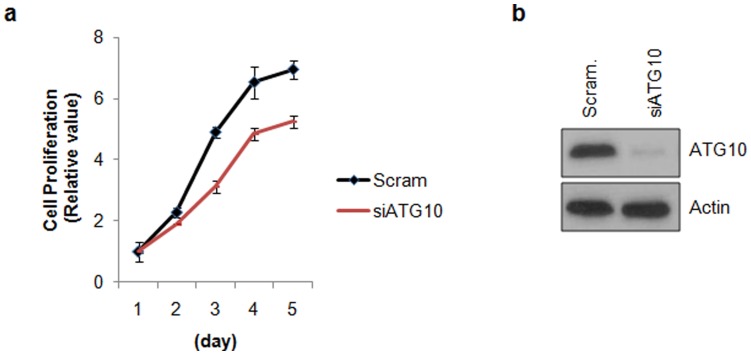
Silencing of ATG10 expression reduces cell proliferation in HCT116 cells.HCT116 cells were transiently transfected with either scrambled negative siRNA (Scram) or ATG10 specific siRNA (siATG10) then the cell proliferation rate was daily determined using a CCK-8 assay kit (a). The down-regulation of ATG10 by siRNA was confirmed with Western blot analysis (b). Data are represented by the mean±SEM (n = 3).